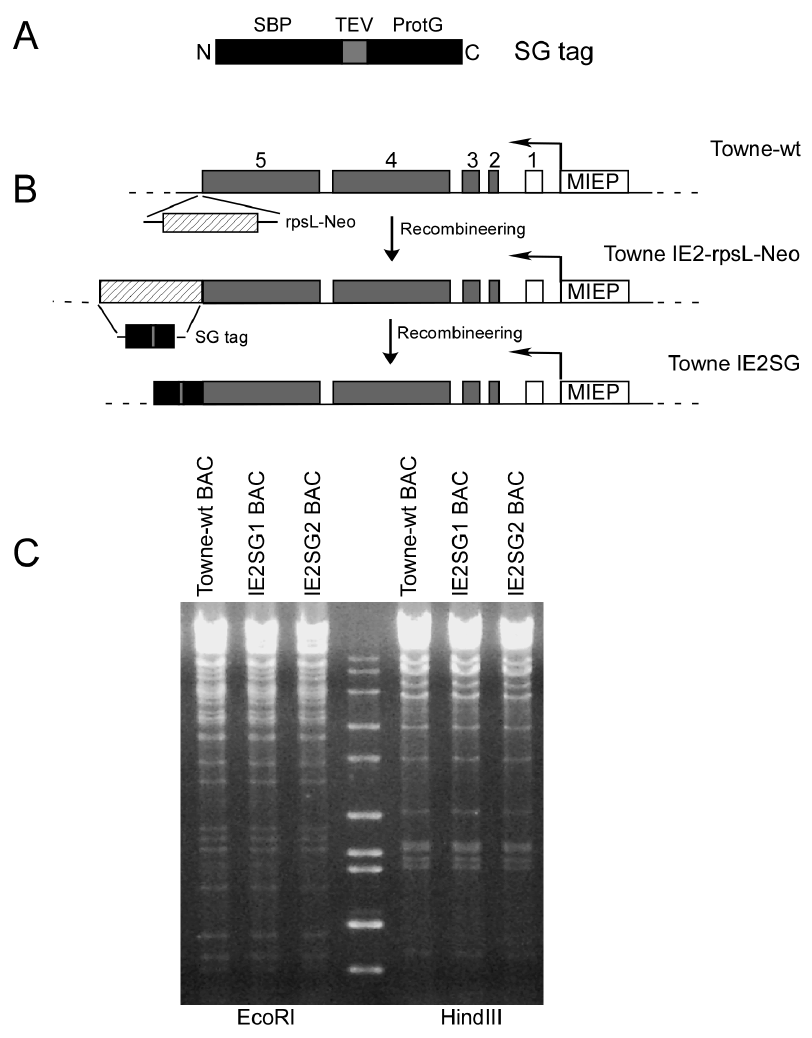
Figure 1. Recombinant HCMVs expressing IE2-p86 protein with a Carboxyl-terminal SG-tag. (A) At the amino terminus (N) of the tag is the streptavidin binding peptide (SBP) followed by the Tobacco Etch Virus (TEV) protease cleavage site and at the carboxyl terminus (C) is the protein G peptide (ProtG) that binds to IgG. (B) Schematic representation of the HCMV MIE gene locus downstream of the MIE promoter (MIEP) of wt Towne BAC. During the first recombination step, the Rspl-Neo cassette was inserted at the 3 9 end of MIE Exon 5 to render DY380 E. coli kanamycin resistant and streptomycin sensitive. The Rspl-Neo was replaced by the SG-tag during the second recombination step as described in the Materials and Methods. (C) Recombinant BAC DNAs digested with restriction endonucleases EcoRI or HindIII and compared to wt HCMV BAC DNA after agarose gel electrophoresis.